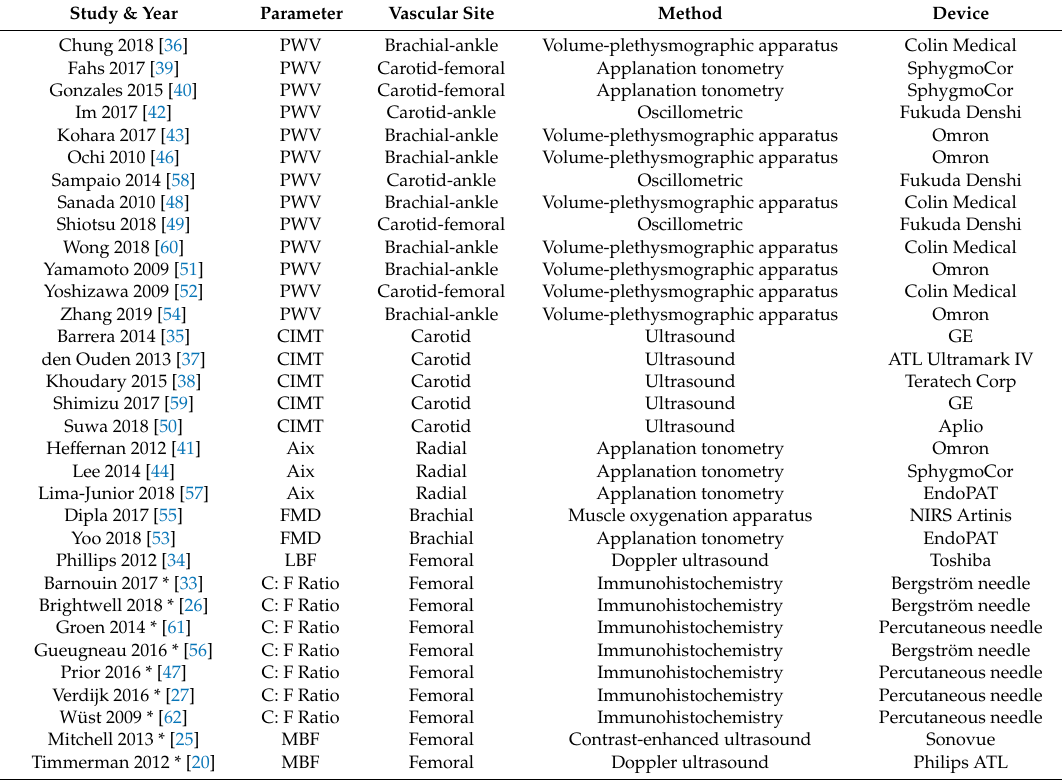
Table 3. Assessment of vascular